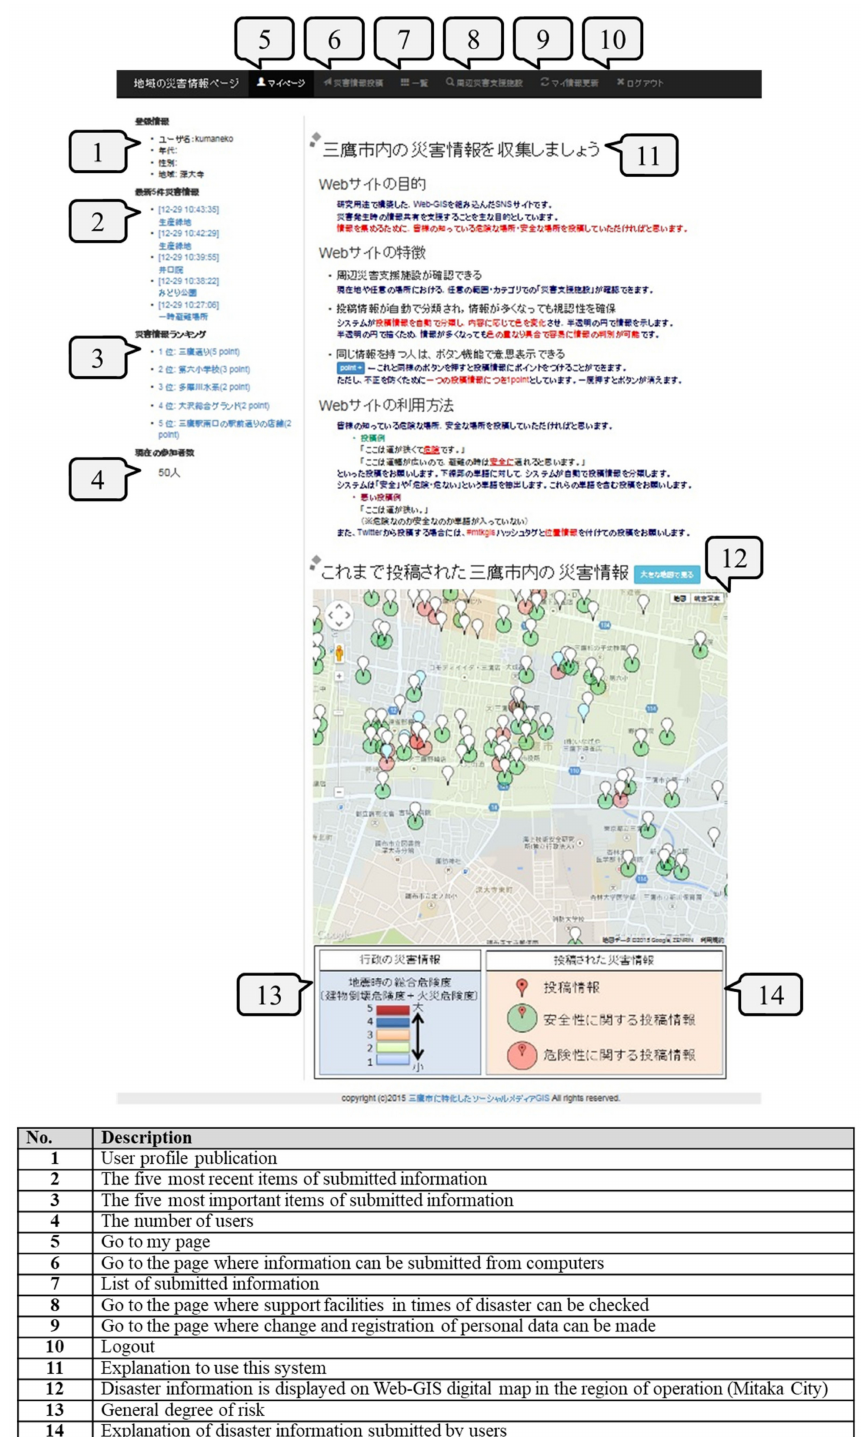
Figure 3. The interface of social media GIS for disaster information system for users’